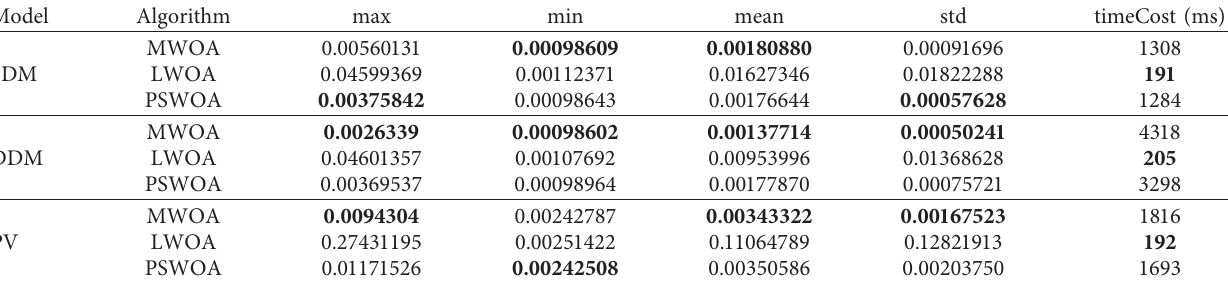
Figure 11: Convergence graphs of MWOA for three models: (a) SDM; (b) DDM; (c) PV. Table 8: Comparisons of MWOA with its variants for three models.